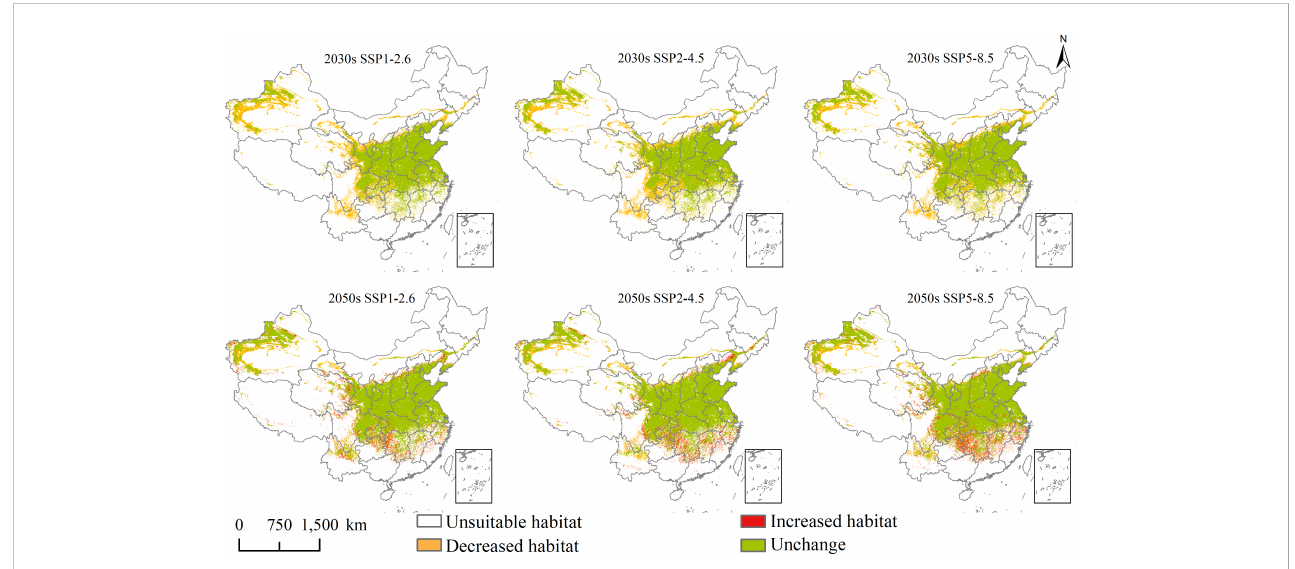
FIGURE 7 Future potential geographical distribution change of Aegilops tauschii under three scenarios in the 2030s and 2050s.